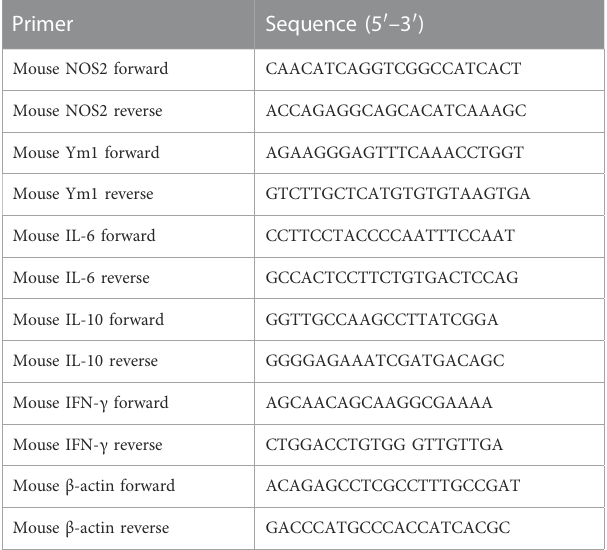
TABLE 1 The sequences of the primers used for q PCR in the